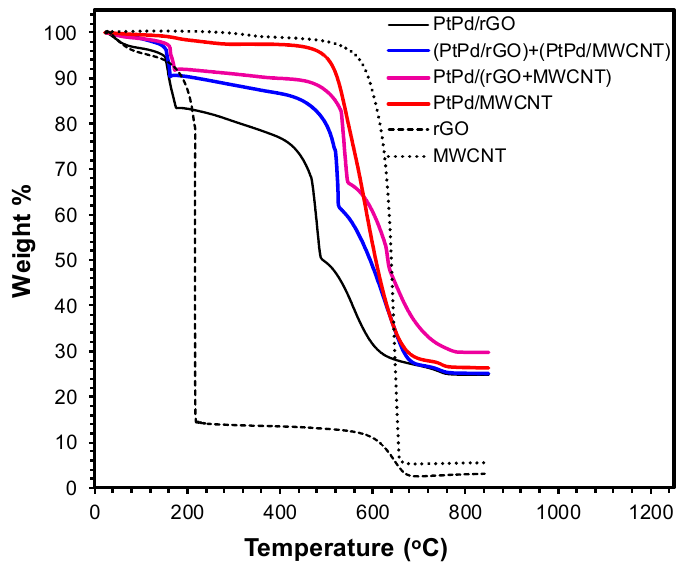
Figure 1. Thermal behavior of carbonaceous supports (partially reduced graphene oxide (rGO) and multi-walled carbon nanotubes (MWCNTs)), bimetallic nanomaterials (PtPd/rGO and PtPd/MWCNT), and hybrid nanomaterials: ((PtPd/rGO) + (PtPd/MWCNT) and PtPd/(rGO:MWCNT)).